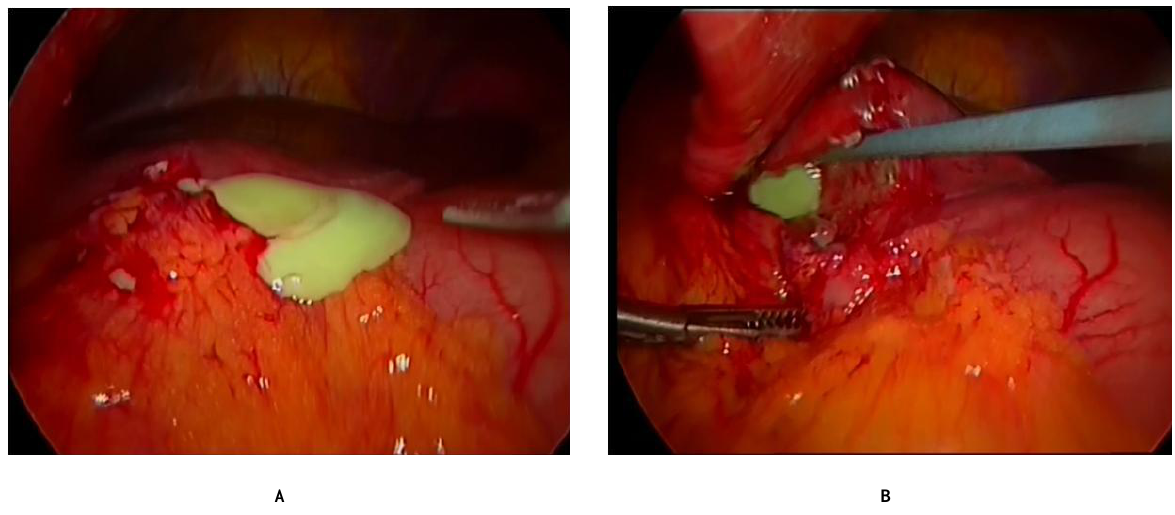
FIGURE 2. (A,B) Laparoscopic imaging showing the liver abscess, which was drained by a suction device.